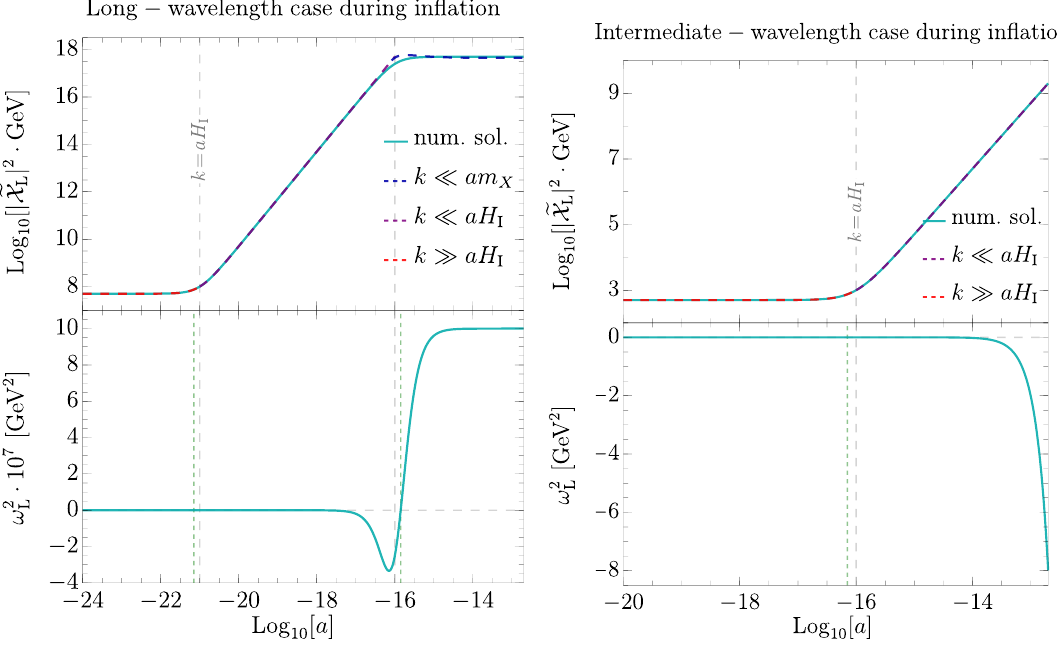
in(cid:13)ation for k (cid:28) a e m X (cid:28) a e H I (left-panels) and a e m X (cid:28) k (cid:28) a e H I (right-panels). In the upper panels cyan solid lines correspond to numerical solutions, while red, purple and blue dashed lines show analytical predictions speci(cid:12)ed in the main text by (2.26), (2.32) and (2.41), respectively. In the lower panel green dashed vertical lines indicate zeros of ! 2 . Here m X =10 8 GeV, H I =10 13 GeV, L w =0 and k =10 (cid:0) 8 GeV ( k =10 (cid:0) 3 GeV) for the left (right)